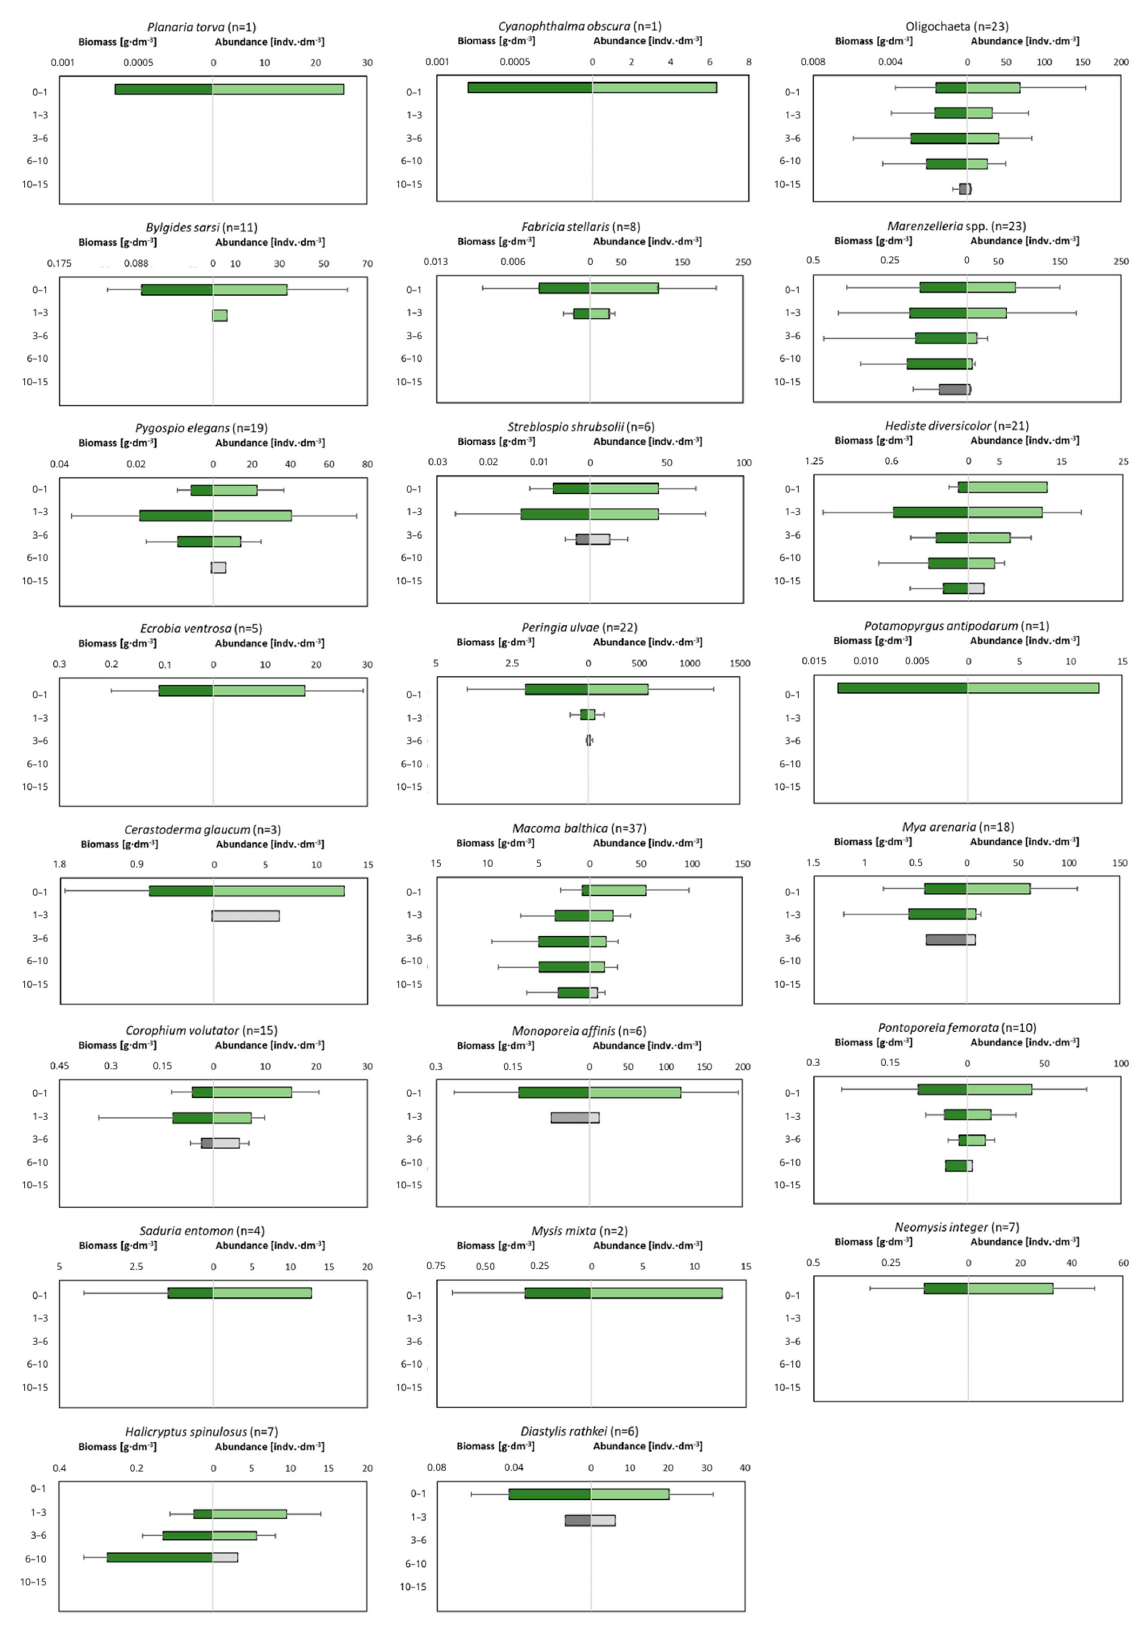
Figure 6. Depth of occurrence of individual macrofaunal taxa in the sediment. Green color indicates to what depth 90% of all organisms are observed. n is number of cores in which particular taxa was